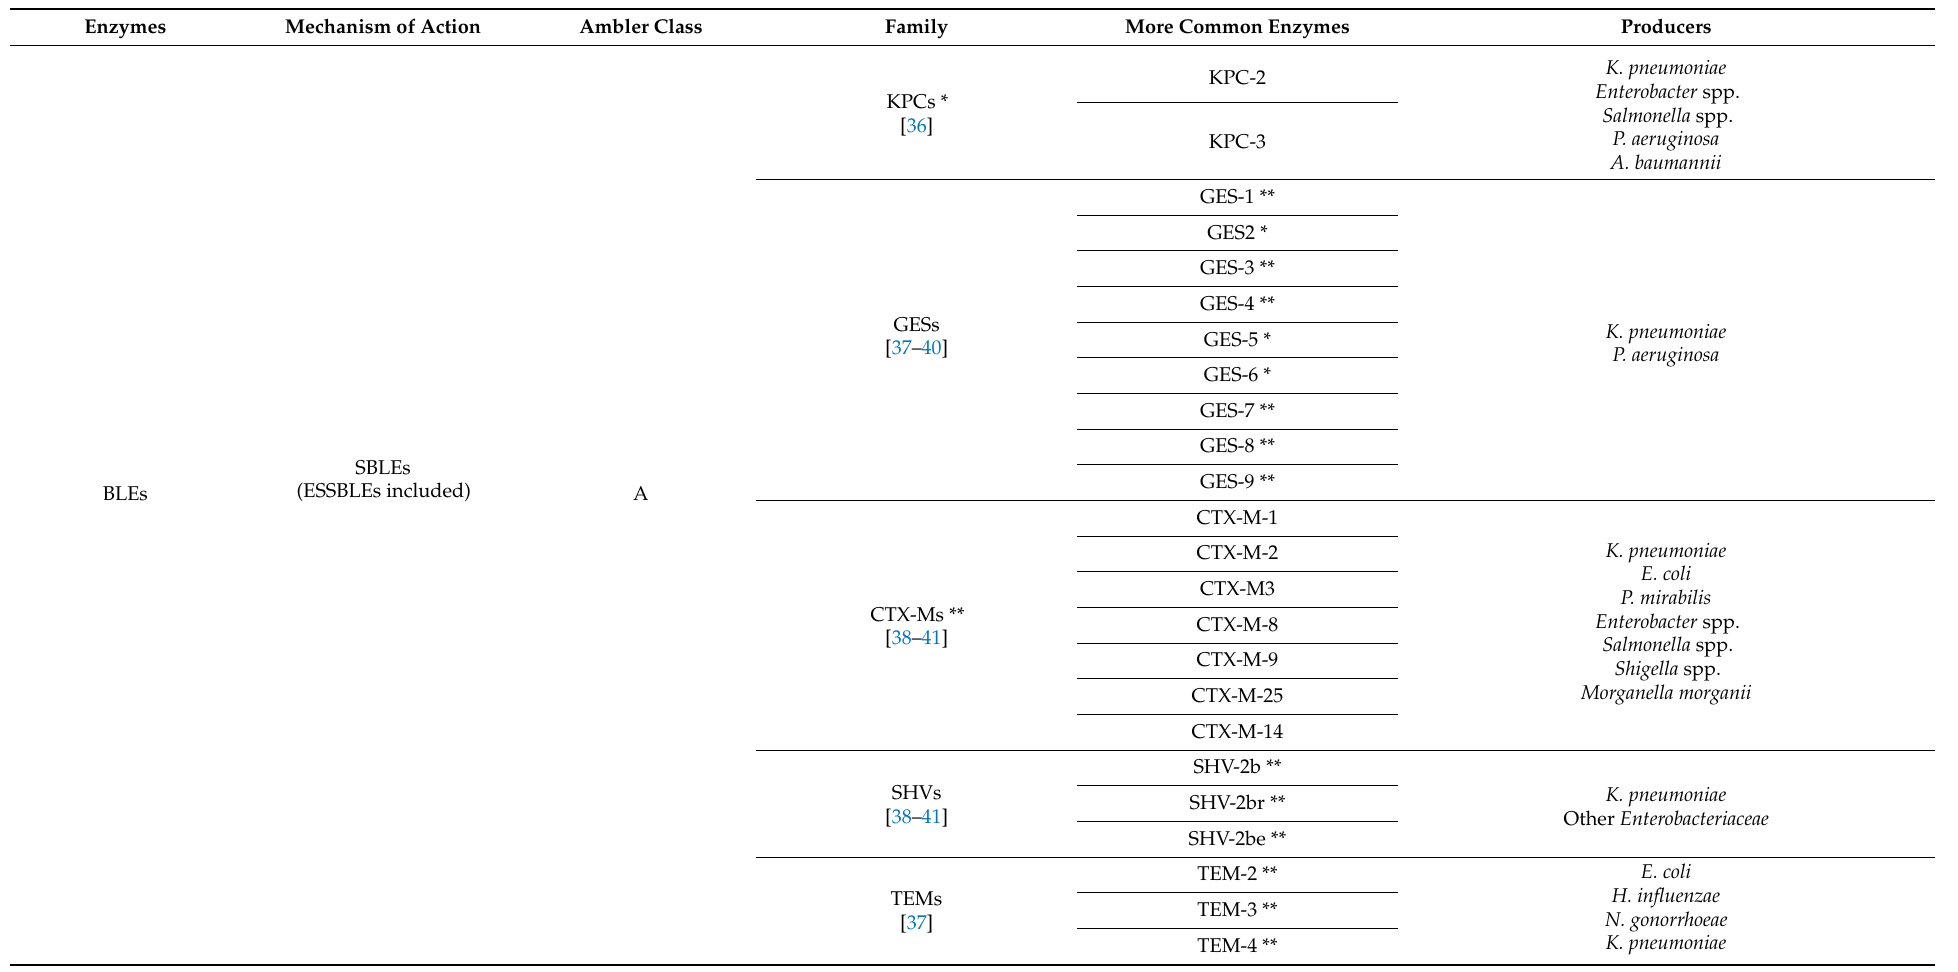
Table 2. β -lactamase enzymes (BLEs)